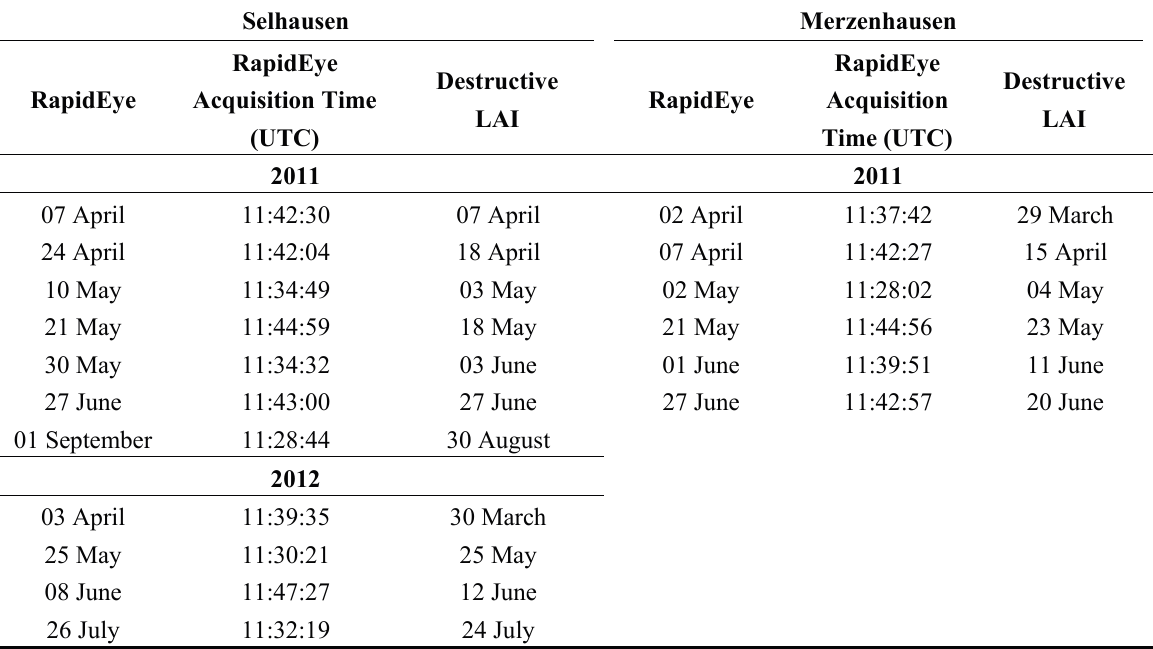
Table 1. In situ Leaf Area Index (LAI) and RapidEye time-series available for this study at both test